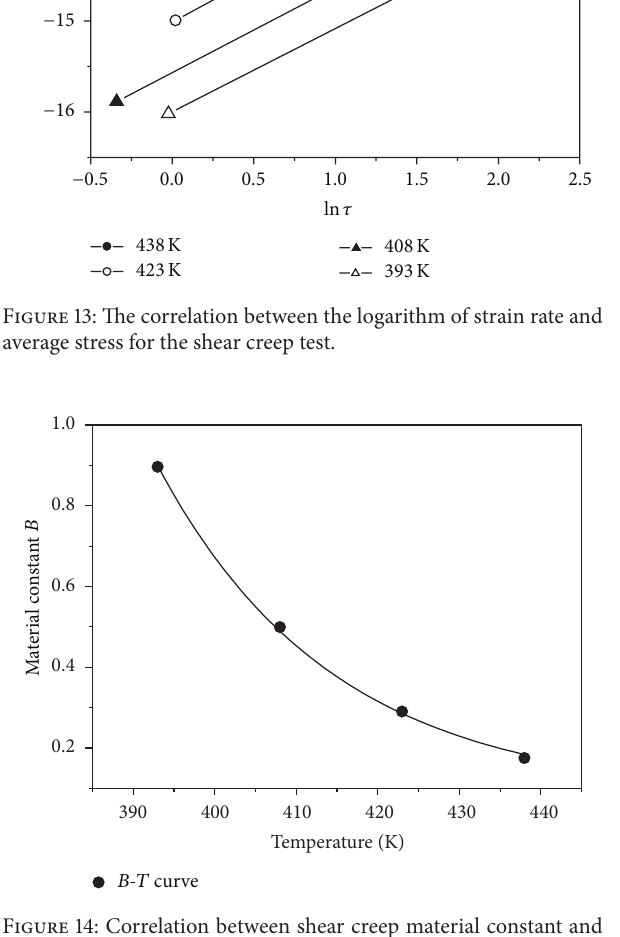
Figure 14: Correlation between shear creep material constant and temperature.